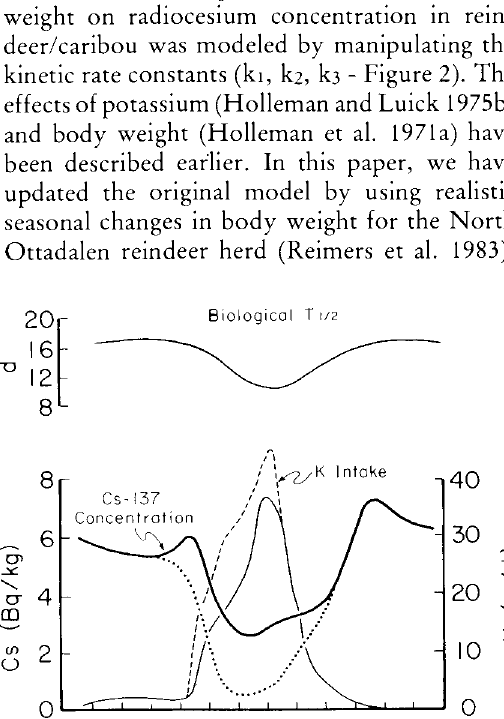
Figure 3. Simulated radiocesium body burdens (Bq/kg) and K intake for reindeer/caribou consuming contaminated forage (600 Bq/ kg. lichen; 300 Bq/kg vascular plants) under 2 diet regimes: (1) year-long consumption of lichen, ( — ) (Gaare and Skogland 1971) and (2) no lichen intake between June 1 and August 15 (-•-). Potassium intakes, shown for the two diets, illustrate higher summer values apparent for animals not consuming lichens at this time.